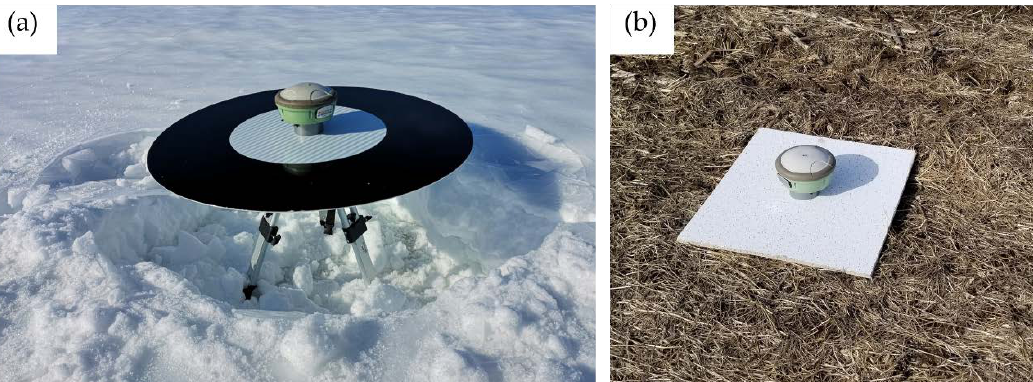
Figure 4. Manmade GCPs: ( a ) Elevated and ( b ) flat. Photos were taken after the lidar surveys with FOIF A30 GNSS receiver on the target surface. FOIF A30 GNSS receiver on the target